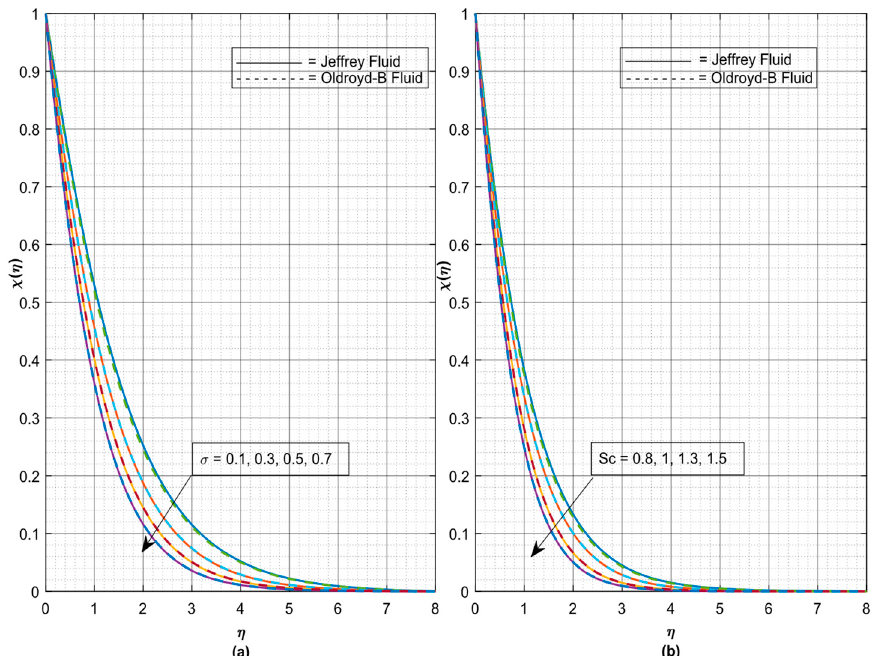
( ) χ η σ on , and ( b ) effect of Sc on